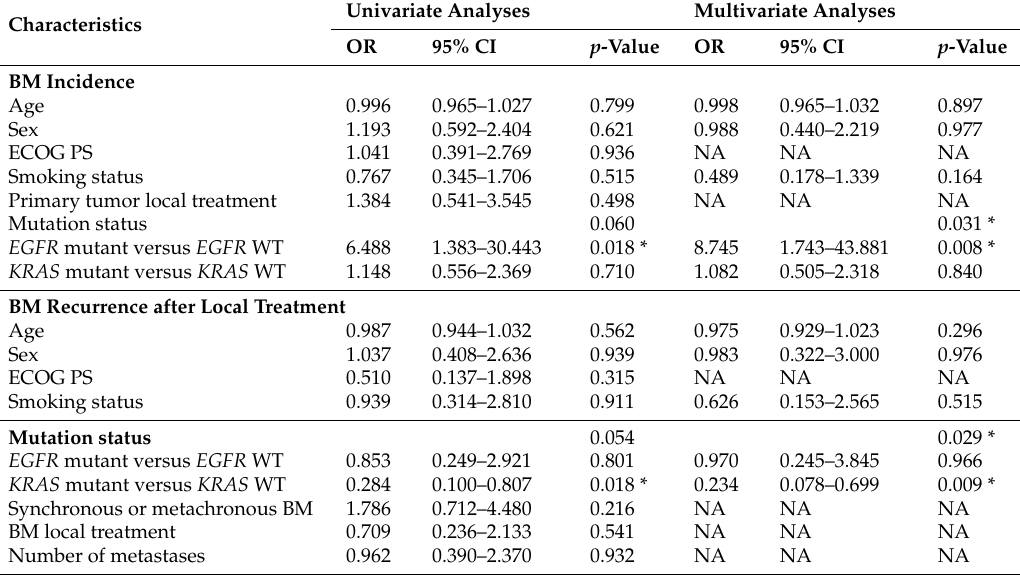
Table 3. Univariate and multivariate analyses of BM incidence and recurrence. OR: odds ratio; 95% CI: 95% confidence interval; BM: brain metastasis; age: <65 versus ≥ 65; sex female versus male; ethnicity: Caucasian versus non Caucasian; smoking status: smoker versus non-smoker; primitive tumor local treatment: surgery or radiation therapy versus no local treatment; Mutation status: EGFR -mutant versus KRAS -mutant versus KRAS and EGFR wild-type tumors; WT: wild-type; BM local treatment: any local treatment (whole brain radiation therapy, surgery or radiosurgery) versus no local treatment;